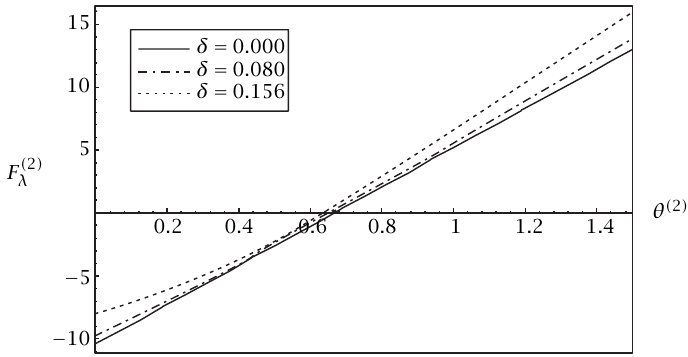
Figure 6.7 . The friction force versus flow rate at Re = 0 . 1, Wi = 0 . 08, and ϕ = 0 .